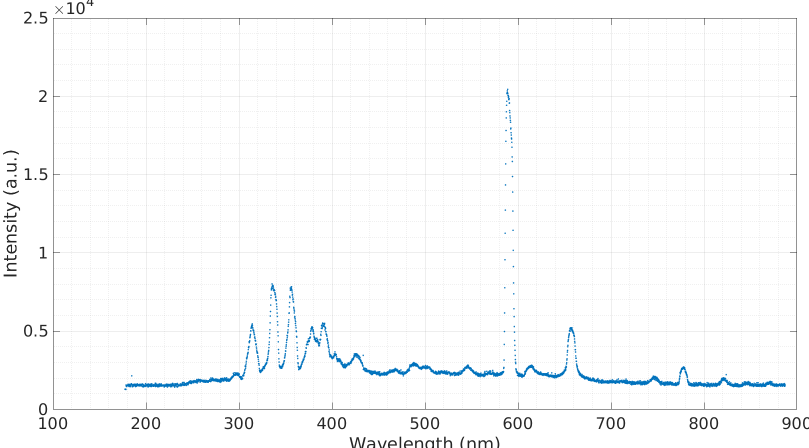
Figure 3. Emission spectra of 3.5% salinity simulated